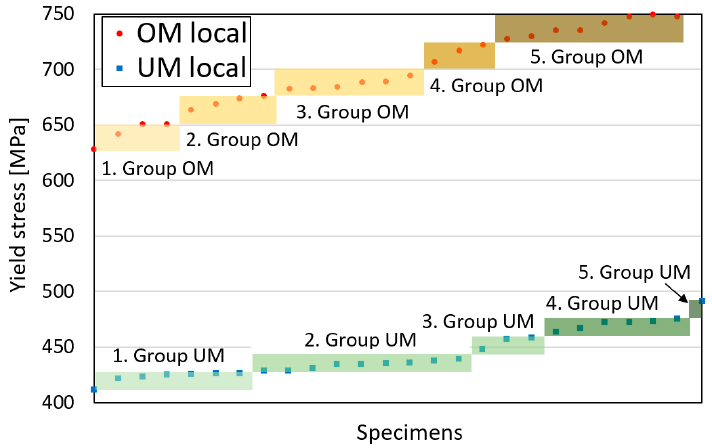
Figure 8. Distribution of yield stress results on 5 equidistant levels for each weld metal.